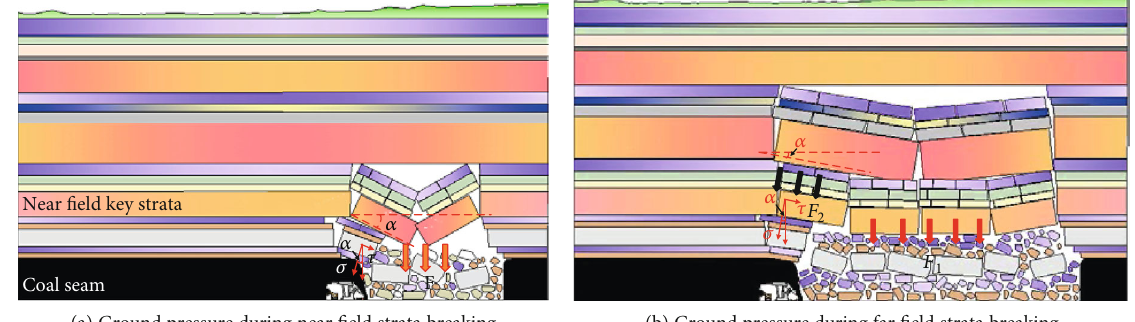
Figure 7: Ground pressure during the breaking of strata at di ff erent levels.